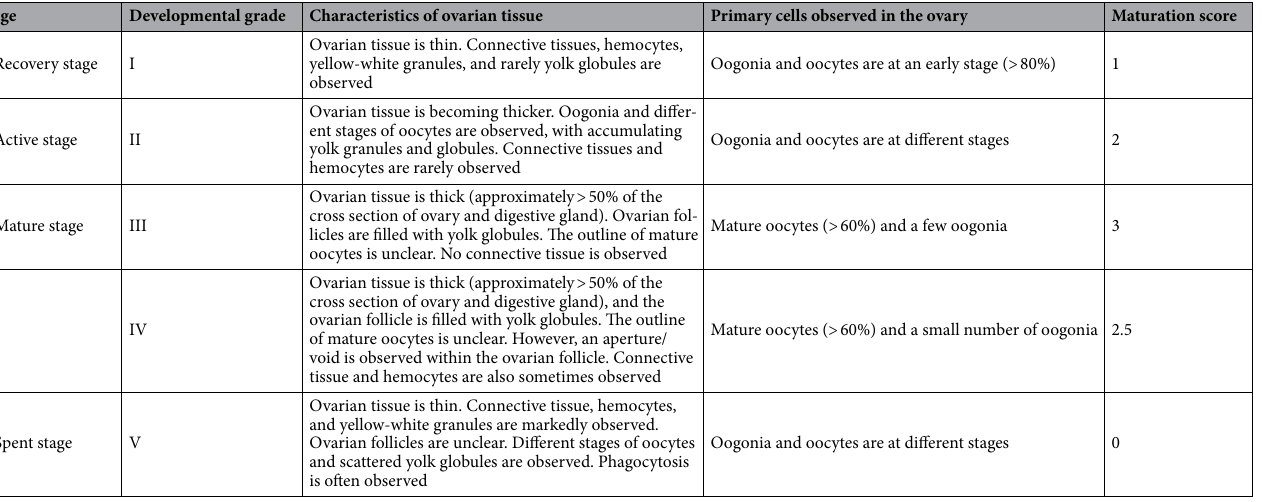
Table 1. Stages, developmental grades, and maturation scores of ovaries of Thais clavigera and Thais bronni